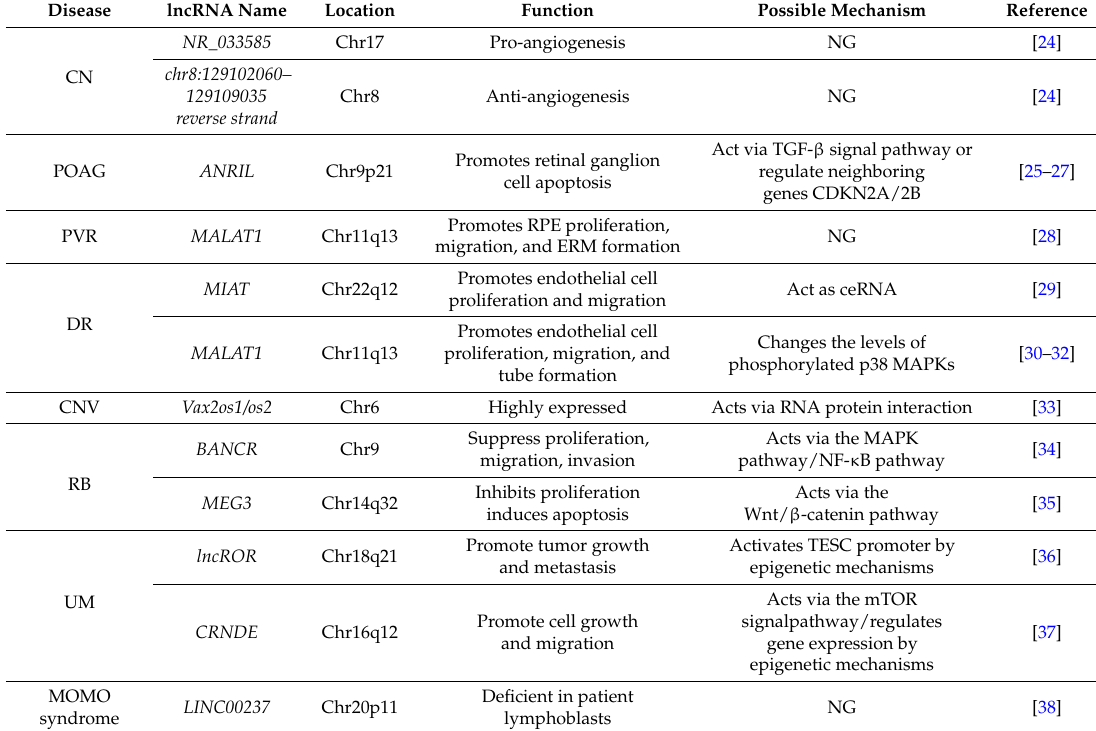
Table 1. Long noncoding RNAs (lncRNAs) involved in different types of ocular diseases.